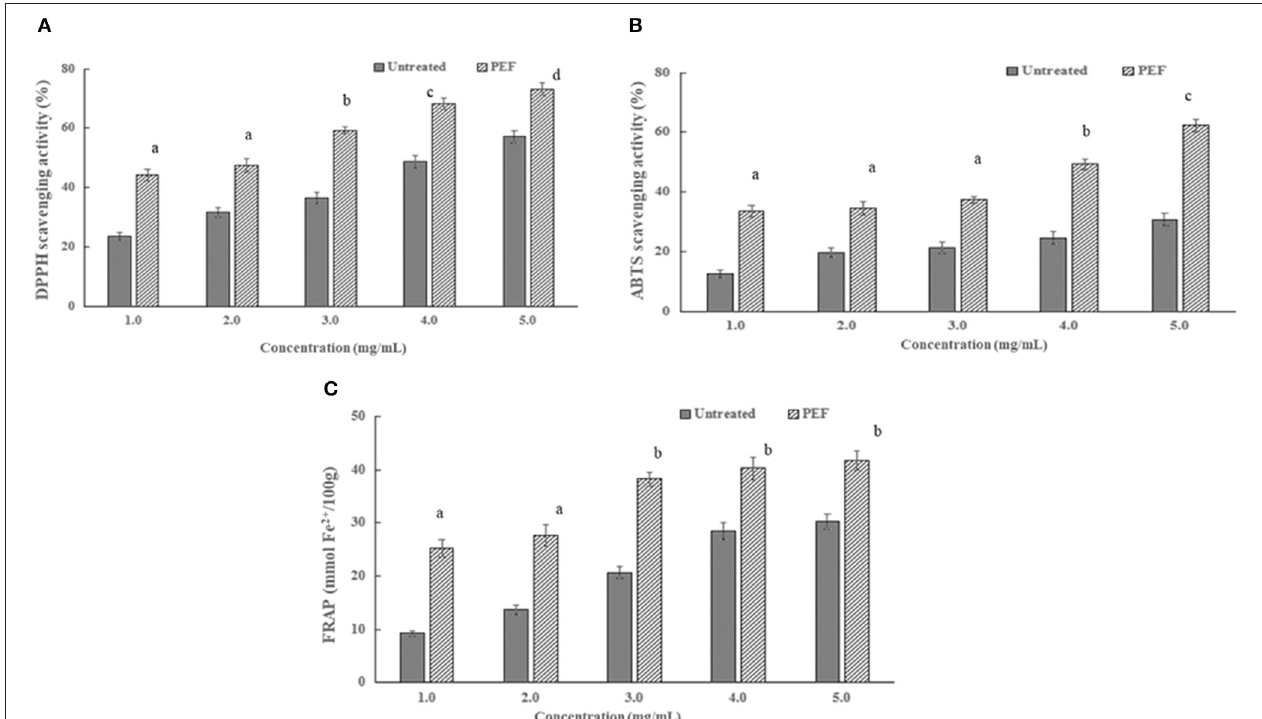
FIGURE 6 | Effect of pulsed electric field treatment on the micro- and macrochange of the orange peel. (A) the ion release from orange peel; (B) orange peel cell membrane disintegration index [the total PEF treatment time (t PEF ) was calculated by the equation t PEF = (pulse number, n) × (pulse width, s)]; (C) the texture properties of the orange peel. The results were expressed as mean ± standard deviation ( n = 3), the different letters indicated that the difference was significant ( P < 0.05) and the same letter was expressed as insignificant difference.